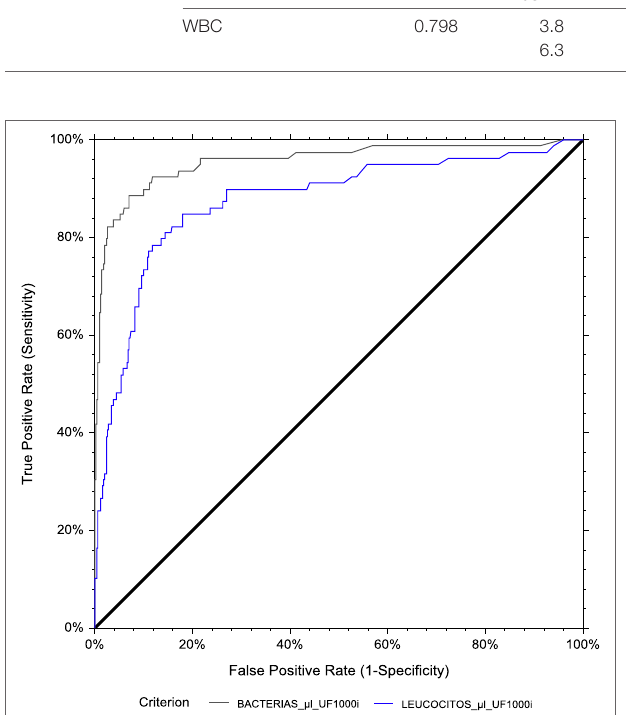
FIgURe 11 | ROC curve analysis for men. The area under the curve (AUC) is 0.956 for bacterial count and 0.876 for leukocyte count by flow cytometry, using culture as the reference